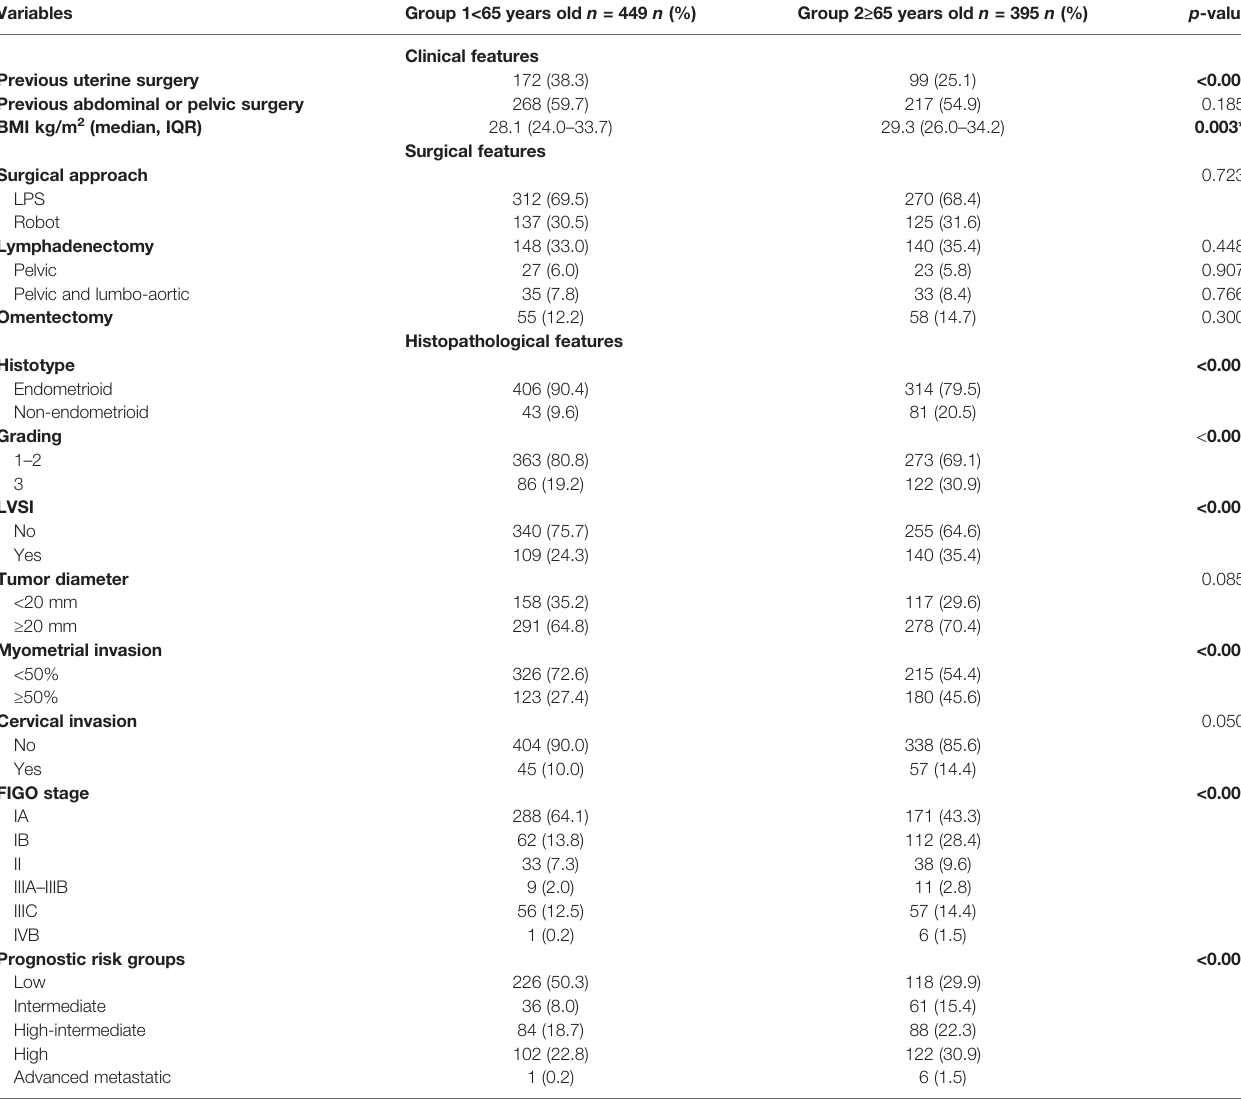
TABLE 1 | Clinical, surgical, and histopathological features of the study population.